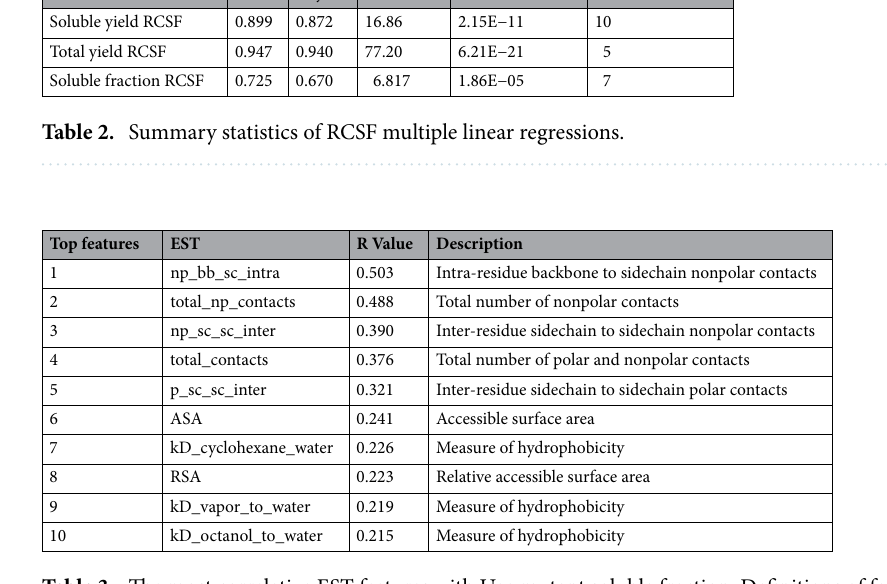
Table 3. The most correlative EST features with Uaa mutant soluble fraction. Definitions of features can be found in Supplementary Table 3.